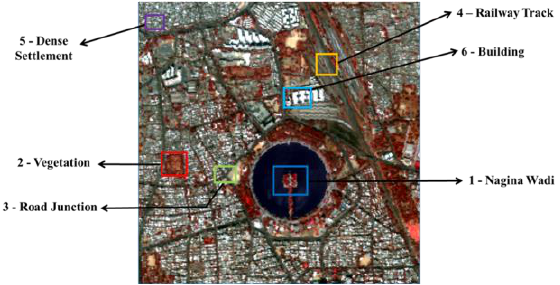
Figure 2. Location of Patches for Visual Inspection